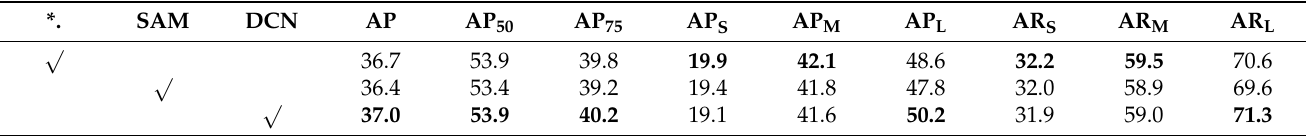
Table 1. The effects of different modules in our Feature Enhancement. *., SAM, and DCN denote without operator, spatial attention mechanism, or deformable convolution, respectively. Bold font indicates the best